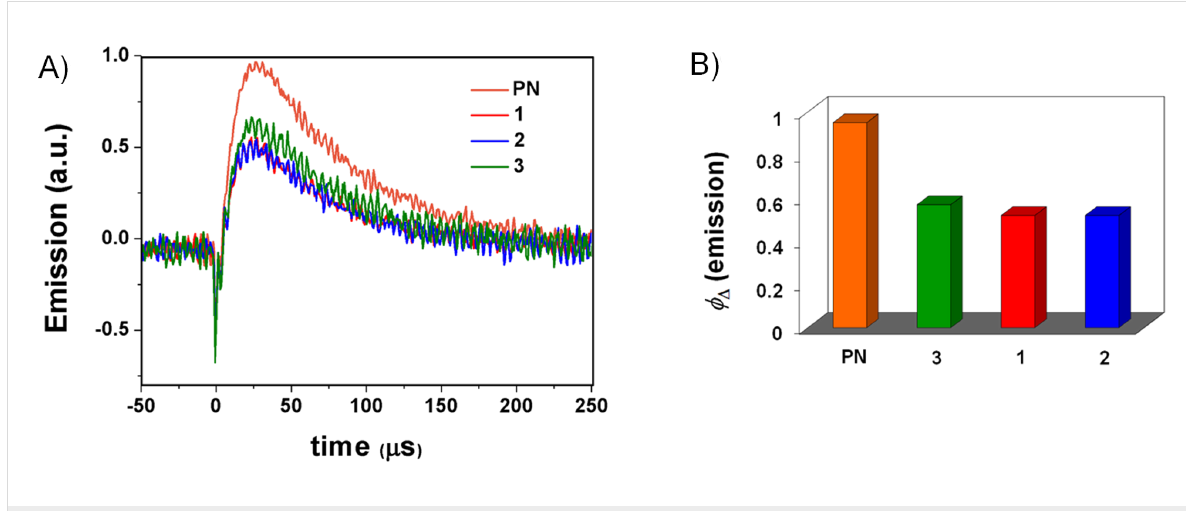
Figure 7: Time-resolved experiments at 1270 nm upon excitation at 308 nm of aerated CH 2 Cl 2 solutions of 1 – 3 , using perinaphthenone as standard for comparison. A) Luminiscence decays of 1 O 2 . B) Formation of 1 O 2 .